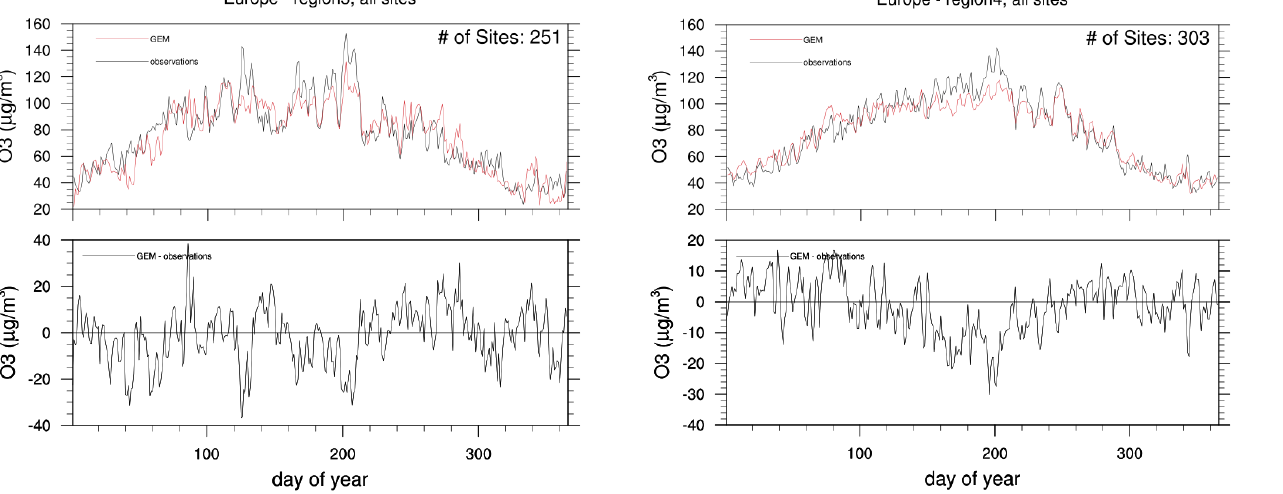
Figure 13. Time series of observed and modelled maximum 8h run- ning averaged ozone concentration averaged for (a) all stations in southern Europe and (b) MBE.